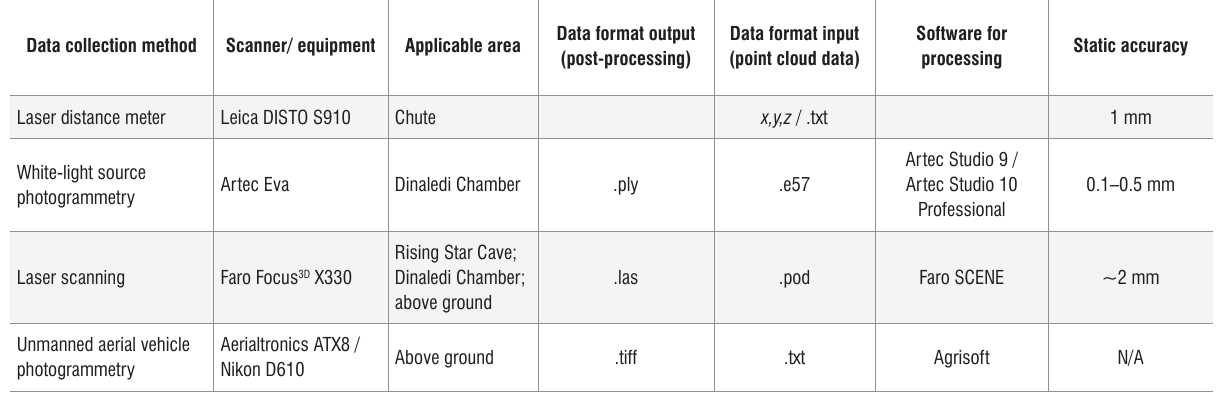
Comparison of three-dimensional data collection methods used at Rising Star Cave and surrounding landscape